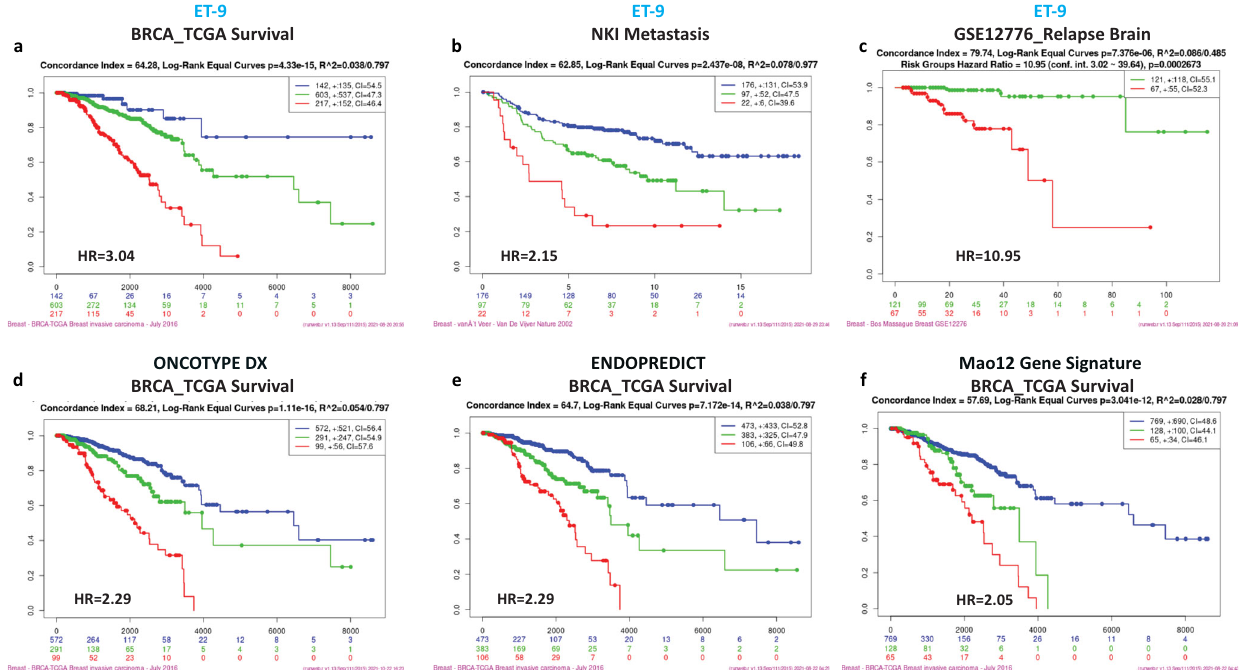
Fig. 4 ET-9 prognostic groups in three different datasets. The Kaplan-Meier (KM) overall survival charts of human breast cancer generated using SurvExpress; high risk (red line), medium risk (green line), low risk (blue line) groups, with auto-selection of cut-off values and maximized risk groups. The relative hazard ratios (HR) were computed using Cox proportional hazard regression analysis 50 . a KM chart of ET-9 expression in human breast cancer in BRCA_TCGA 2016 dataset, HR: 3.04 (CI: 2.2 – 4.1). b KM chart of ET-9 expression in human breast cancer in NKI dataset, HR: 2.15 (CI: 1.6 – 2.8). c KM chart of ET-9 expression in human breast cancer in GSE12276 dataset, HR: 10.95 (CI: 3.0 – 39.6). d KM chart of the 21-gene Oncotype in BRCA_TCGA 2016 dataset, HR: 2.29 (CI: 1.61 – 2.97). Two genes TRFC and RPLPO not found in this dataset. e KM chart of a 12-gene signature (Endopredict) in BRCA_TCGA 2016 dataset, HR: 2.29 (CI 1.8 – 2.8). f KM chart of a 12-gene signature 62 in BRCA_TCGA 2016 dataset, HR: 2.05 (CI 1.6 –